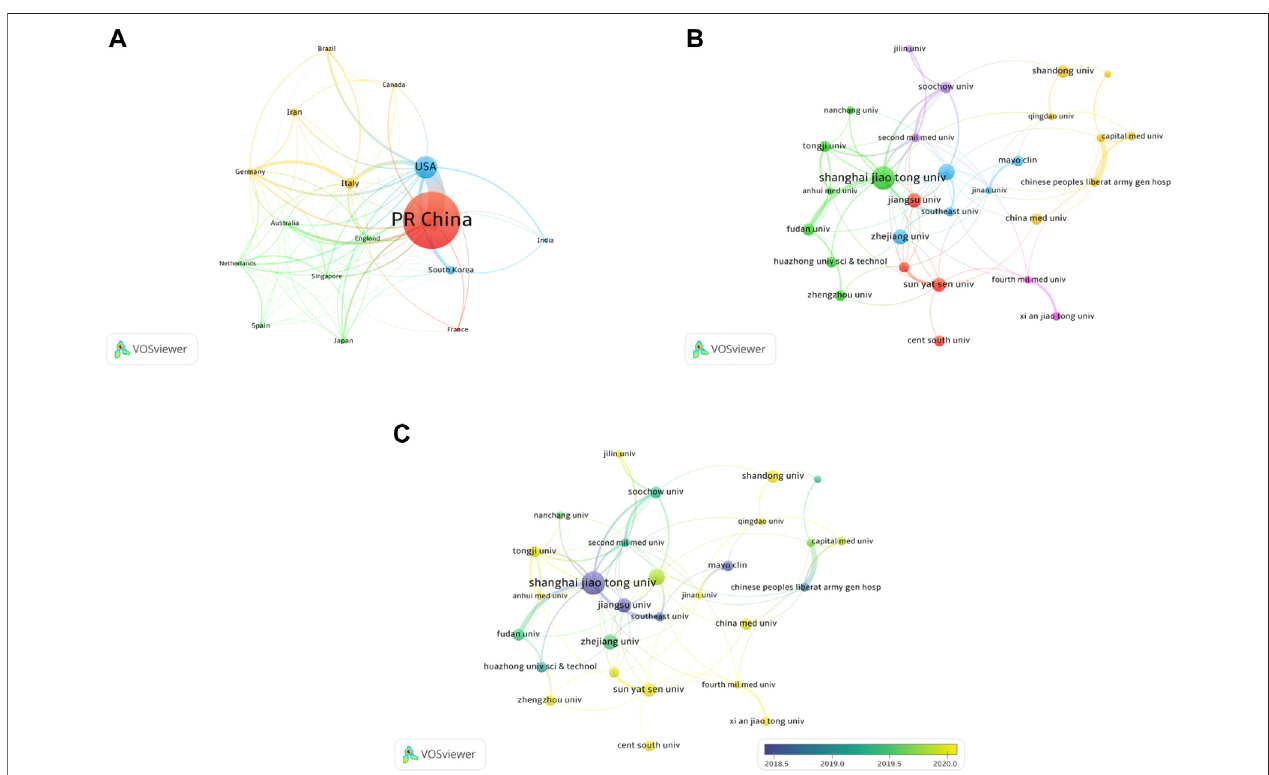
FIGURE3| Co-authorshipanalysisofcountriesandinstitutions. (A) Networkmapofco-authorshipbetweencountrieswithmorethan15publications. (B) Network map of co-authorship between institutions with more than 15 publications. (C) Network map of co-authorship between institutions with more than 15 publications according to average publication year (blue: earlier, yellow: later).